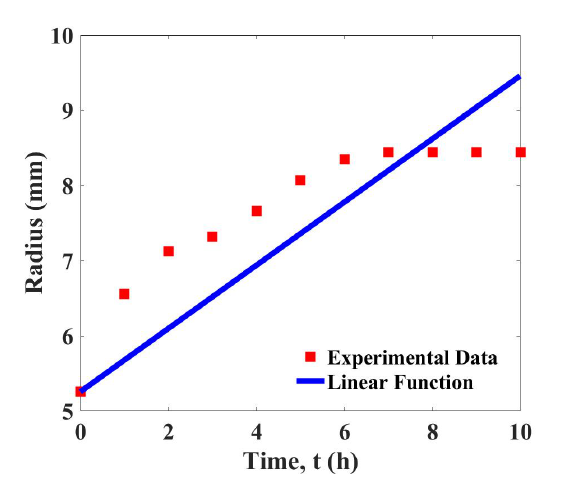
Figure 2. Curve fitting of the growth data and the linear function, X ( t ) .